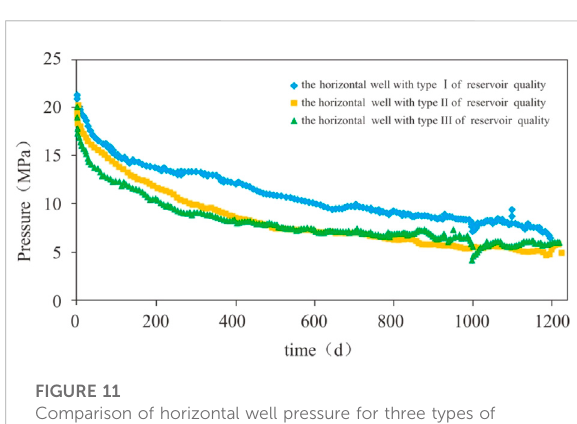
FIGURE 10 Comparison of production of horizontal wells with three types of reservoir qualities.